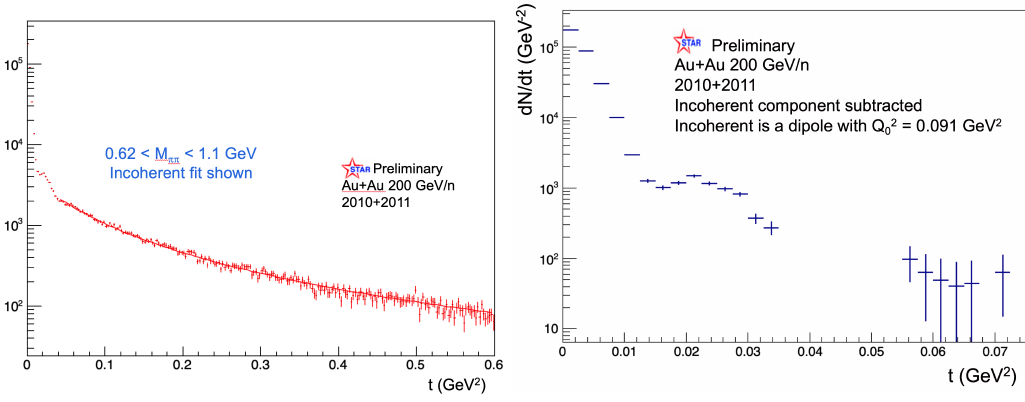
Figure 2: (a) d σ/ dt for dipion pairs with 0.62 < M ππ < 1.3 GeV, with the dipole fit shown by the solid red line. (b) d σ/ dt , after subtraction of the coherent contribu- tion, with an expanded t scale, showing the coherent